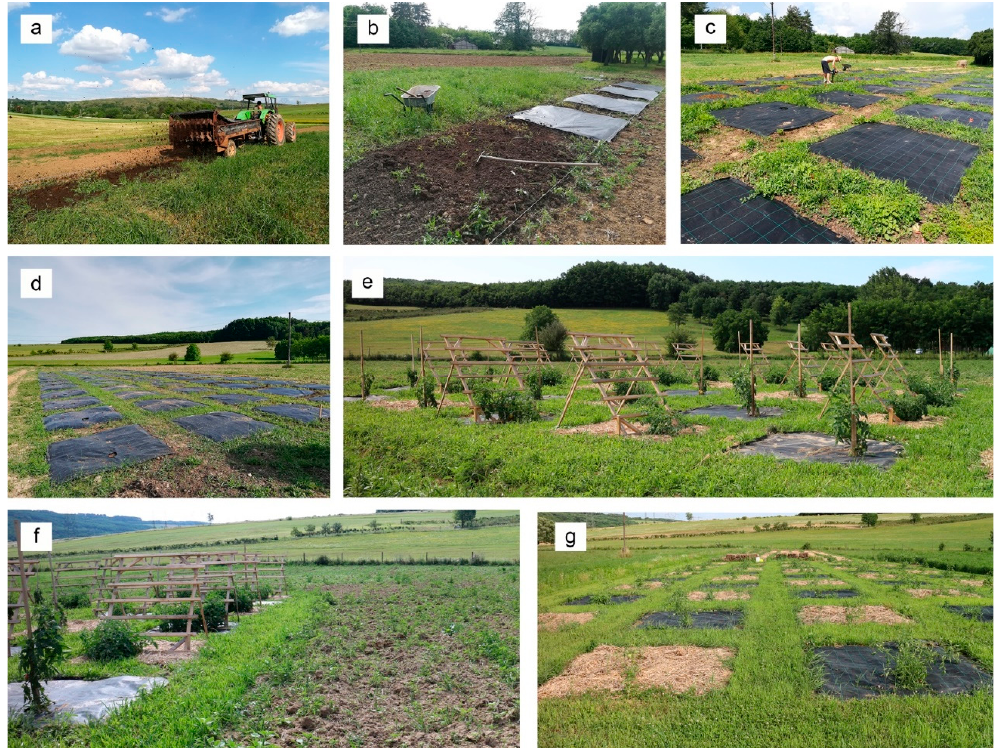
Figure 1. The experimental site at Ő sagárd ( a ) Before setting up the microplots, manure was evenly spread on the green fallow in 2018; ( b ) Manure was raked into the frame of microplots to clear the path area in 2018; ( c , d ) Weed control fabric “islands” were laid on the manure rectangles in 2018; ( e ) The experimental site with the tomato plants with different pruning and mulching treatments in 2018; ( f ) The mulched microplots and grassy path on the left, tilled fallow before preparing seeding bed for alfalfa on the right in 2018; ( g ) Microplots after tomato planting but before setting up the stakes and trellises in 2019. On the upper right corner, alfalfa sown in the previous year is already visible with its 40–50 cm height.